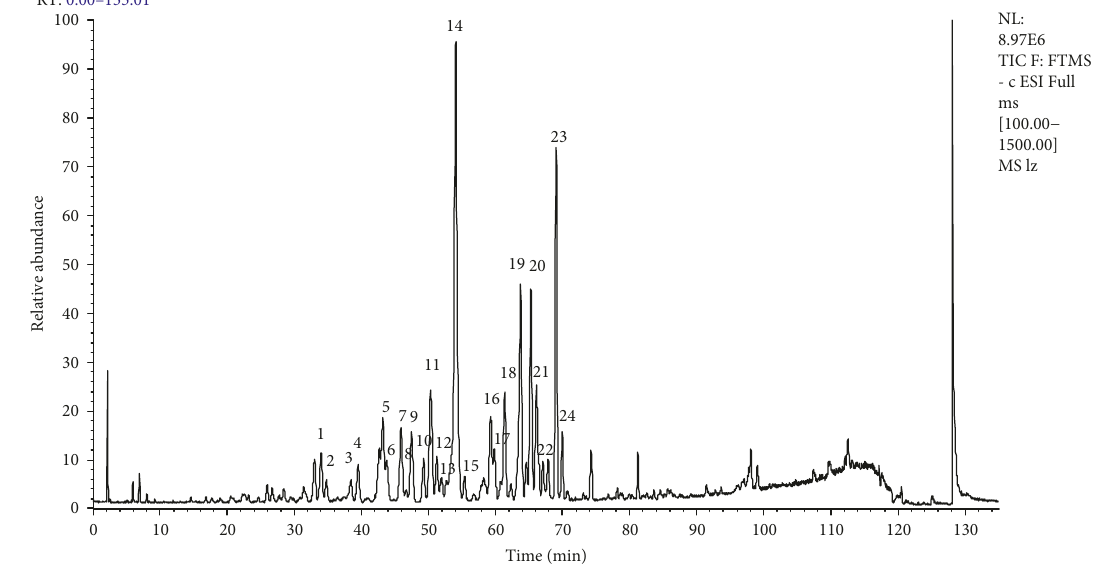
Figure 3: The total ion chromatograms (TICs) of the extract from Ganoderma by LC-LTQ-Orbitrap-MS n in negative ion